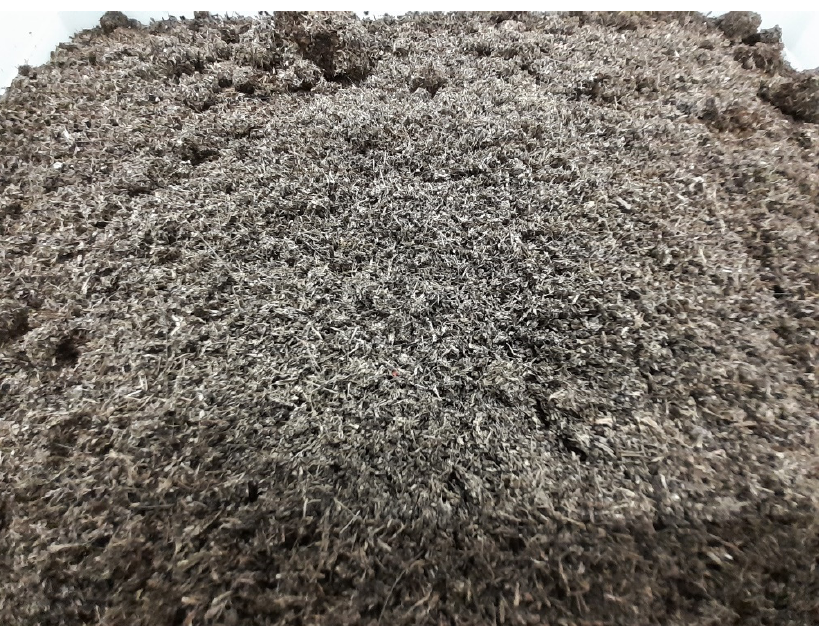
Figure 2. Digestate solid fraction. Table 1. Composition of blends used for the production of solid biofuels.